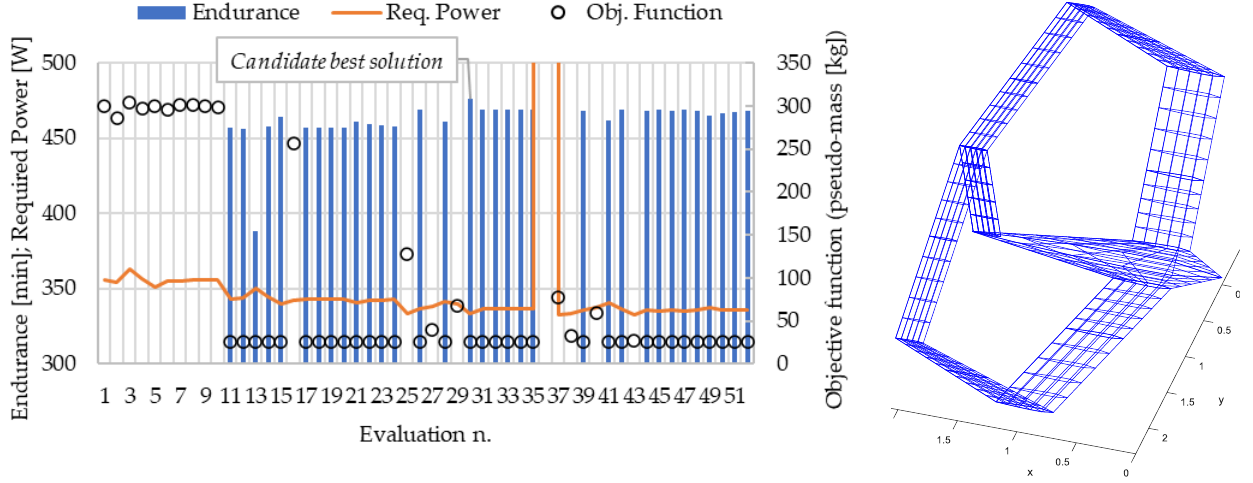
Figure 12. Results of the box-wing UAV optimization ( left ) and the graphic representation of the candidate best solution ( right ).